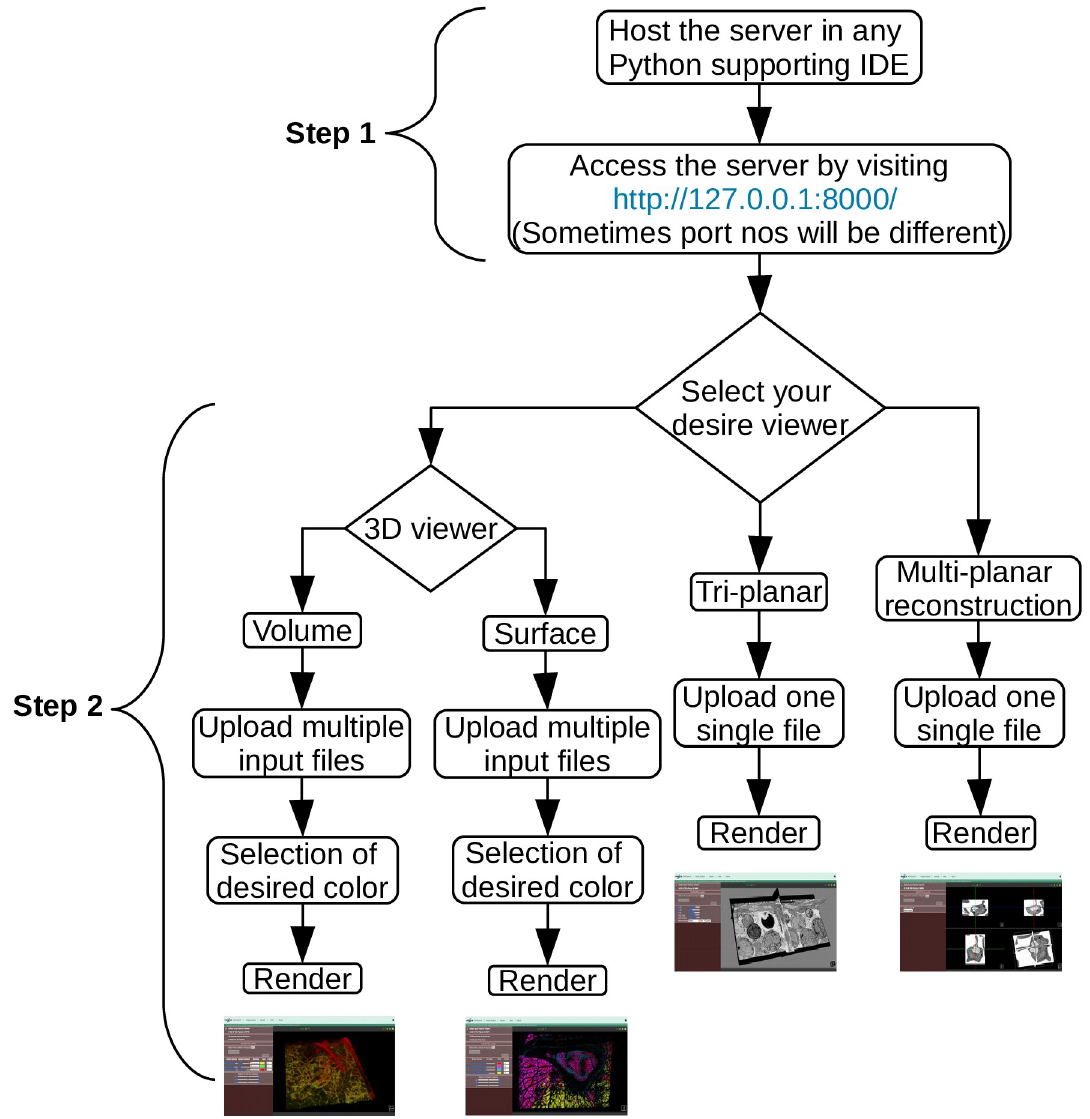
Fig 5. Flowchart depiciting the inner working mechanism of our viewer. Step 1 describes how to host the server locally, and Step 2 explains how the viewer works, from describing the desired viewer to clicking the render